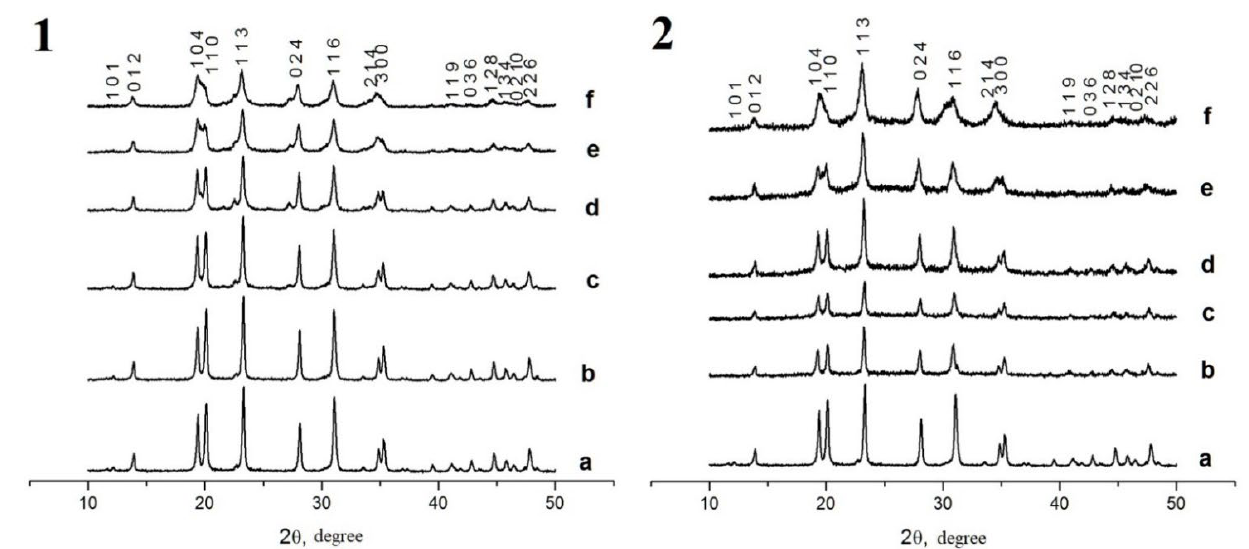
Figure 7. XRD data. Phosphate Ca 1-x Zr 2 (PO 4 ) 3-x (XO 4 ) x compounds, X = Mo ( 1 ), W ( 2 ), x = 0 (a), 0.1 (b), 0.2 (c), 0.3 (d), 0.4 (e), 0.5 (f).